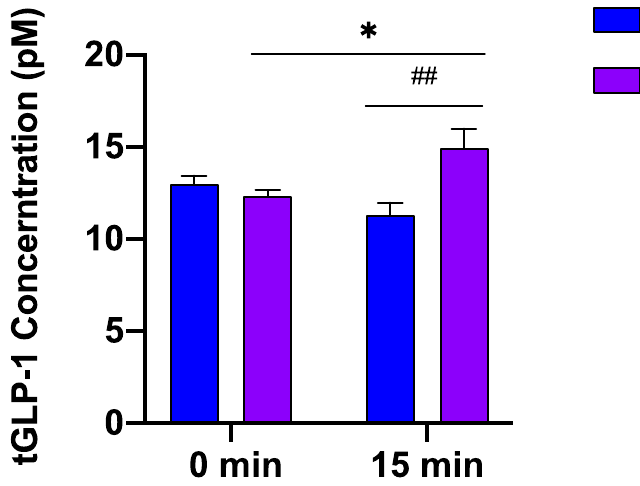
Figure 3. Acute administration of genipin increased plasma GLP-1 in vivo. Mice were orally admin- istered 50 mg/kg genipin or vehicle. Blood samples were drawn before treatment (0 min) or 15 min after gavage, with total GLP-1 levels in plasma measured using an ELISA kit. The experiment was repeated twice at a 1-week interval. Data are shown as means ± SEM (n = 11 mice/group). * p < 0.05 vs. 0 min and ## p < 0.01 vs. control.